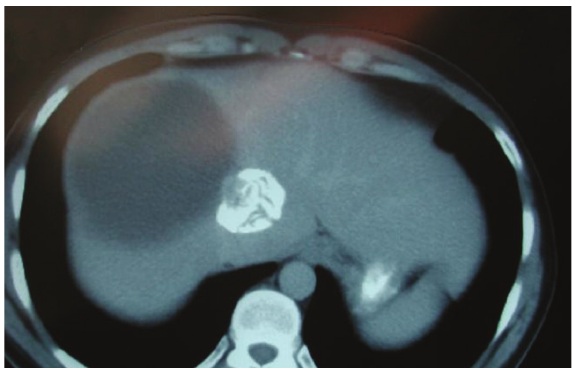
Figure 1: CT after 3 month course of albendazole and praziquantel. Table 1: Gharbi classification of hepatic echinococcal cysts.